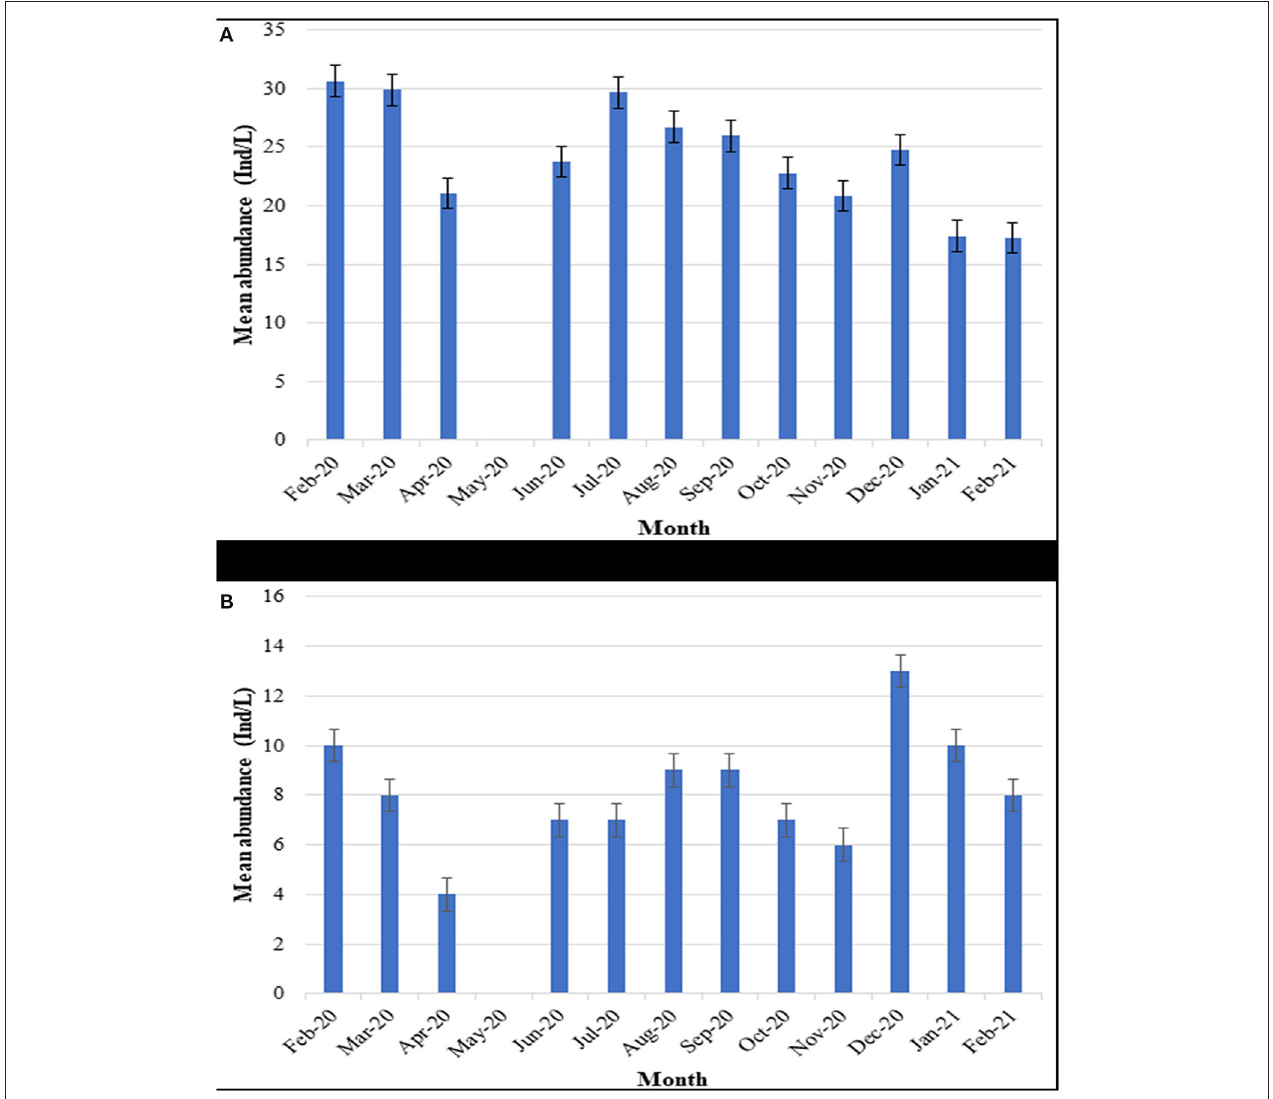
FIGURE 4 | Temporal variations of phytoplankton and zooplankton abundance in Lake Kanyaboli from February 2020 to February 2021 [ (A) : monthly variations of phytoplankton; (B) : monthly variations of zooplankton].